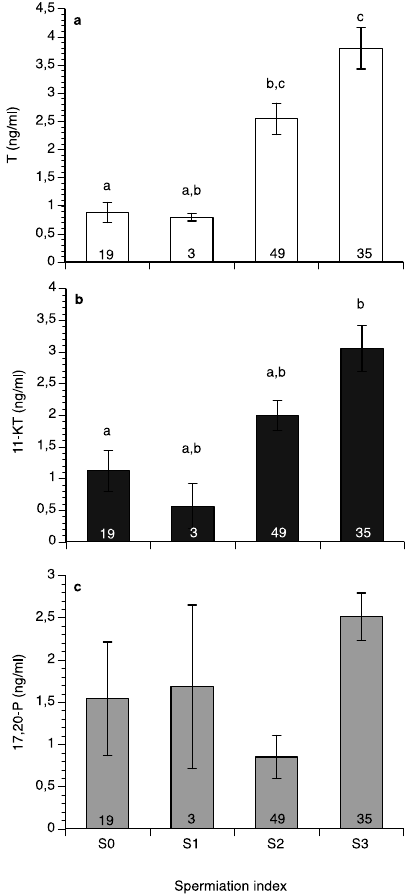
Figure 9. Mean ( ± SEM) plasma testosterone ( a ), 11-ketotestosteone (11-KT) ( b ) and 17,20 β -dihydroxy-progesterone ( c ) of wreckfish in relation to spermiation index (See Figure 5). Different letter superscripts indicate statistically significant differences among spermiation indexes, and numbers inside the bars indicate the number of males at each spermiation index stage (one-way ANOVA, Tukey’s HSD test, p < 0.05).